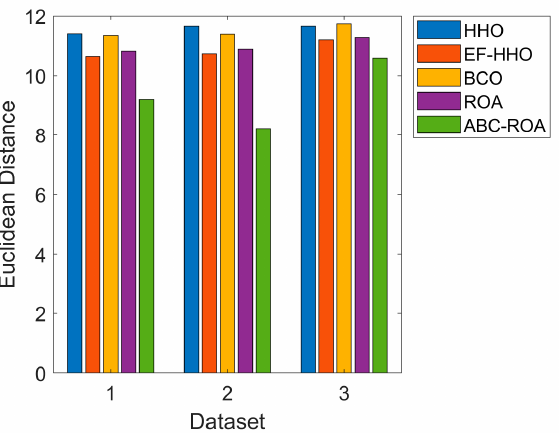
Figure 5. Effectiveness analysis on the offered blockchain-based privacy preservation model using Euclidean distance.